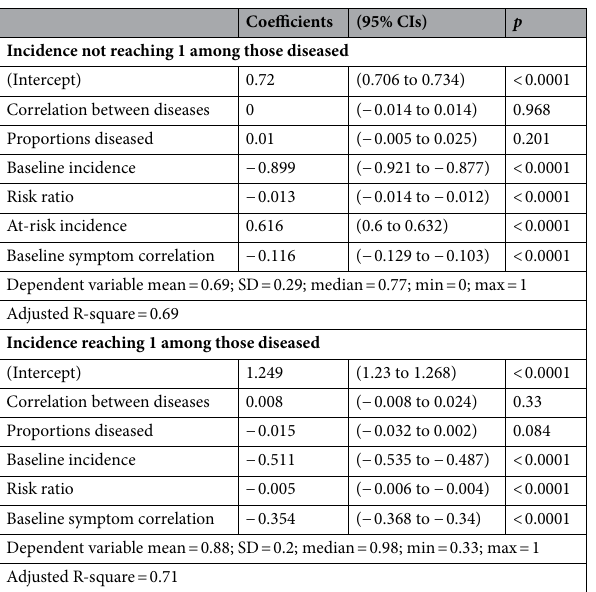
Table 10. Effects of baseline incidence, proportions diseased, risk ratios, and baseline symptom correlations on the specificities obtained from the maximal area under the receiver operating characteristic curve using at most 40 symptoms for disease diagnosis. CI confidence interval, SD standard